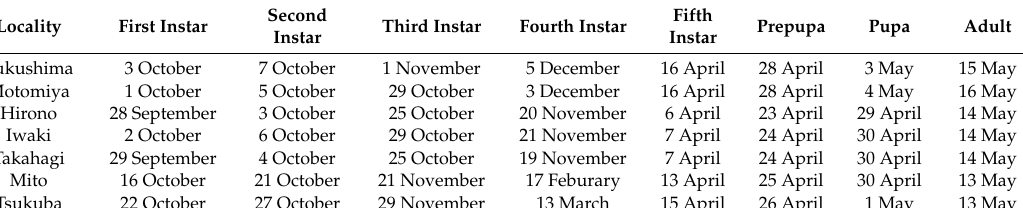
Table 5. Starting dates of each instar and stage in 2010–2011.